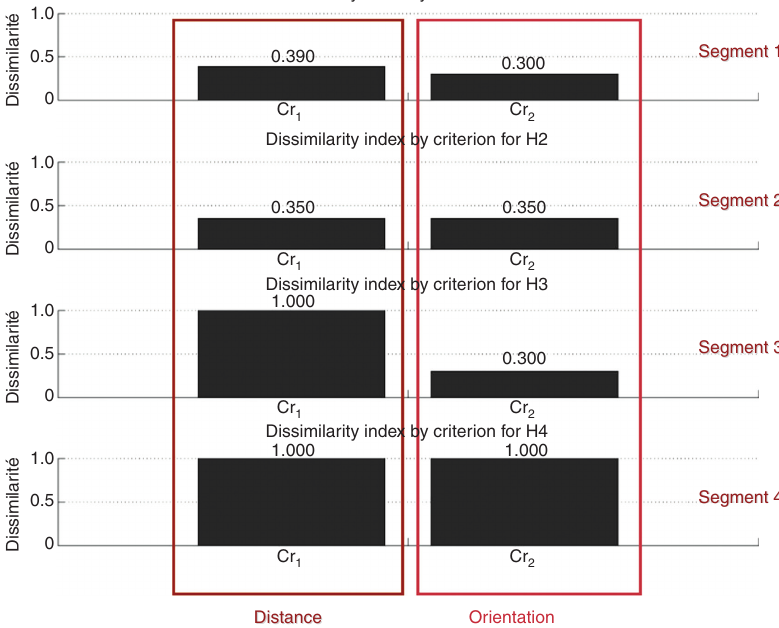
by the Criterion for the Selected Segments. ij